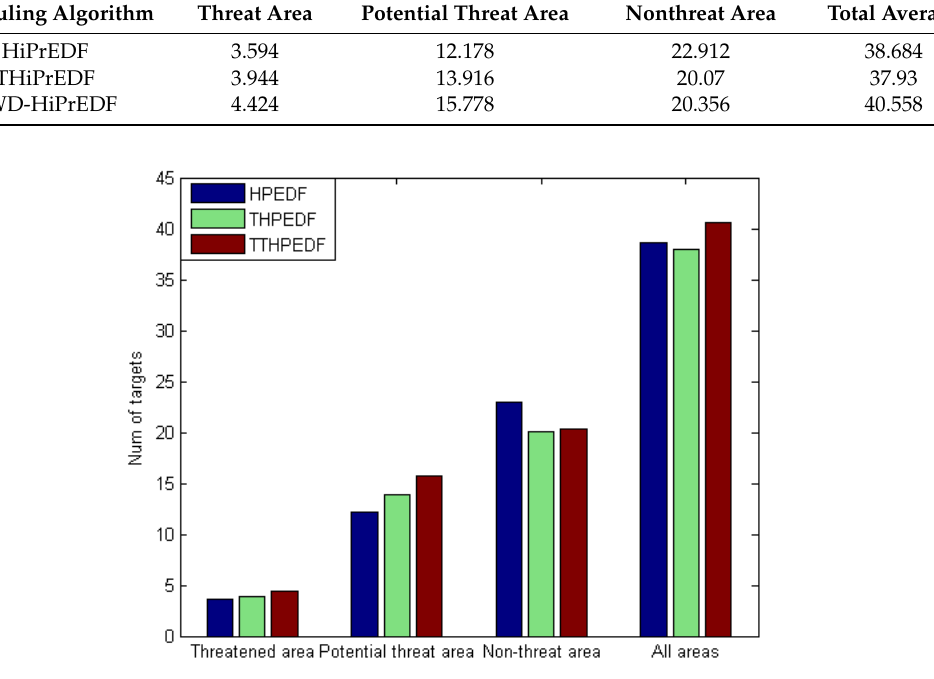
Figure 5. Number of targets in the tracking state under the three scheduling algorithms. Table 7. The proportions of targets in di ff erent tracking areas in each scheduling interval under the three scheduling